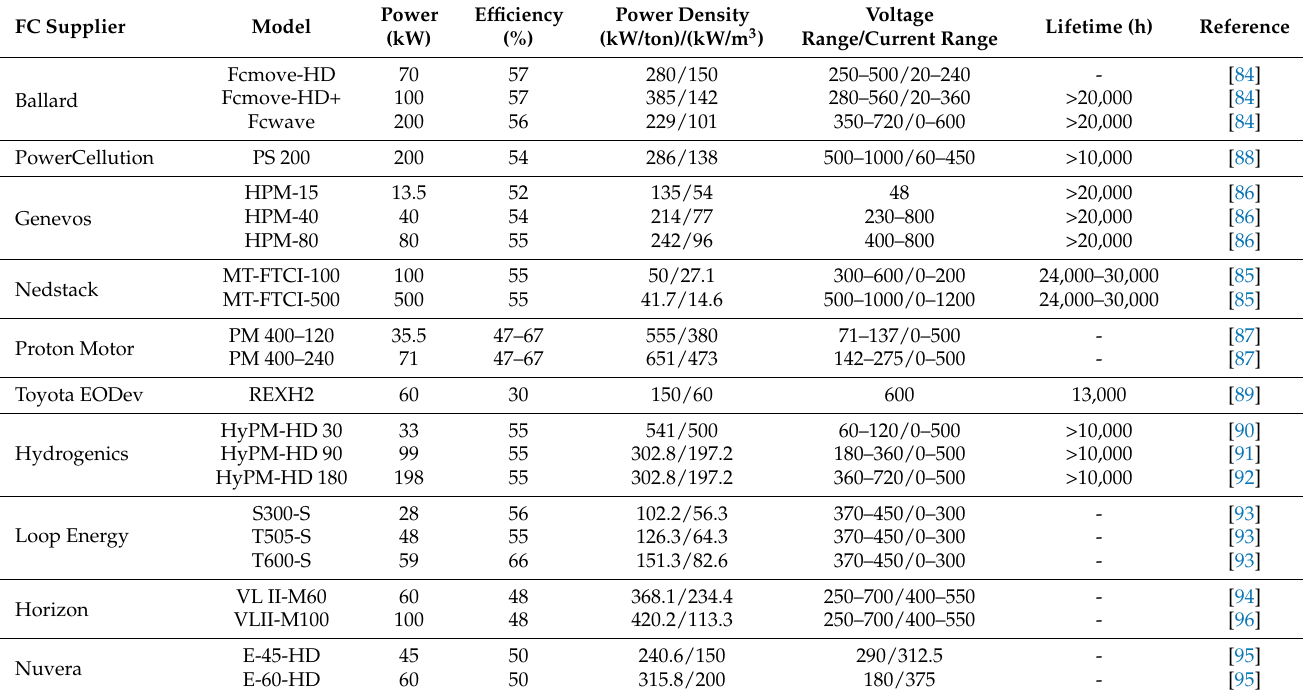
Table 2. Technical specifications of PEMFC